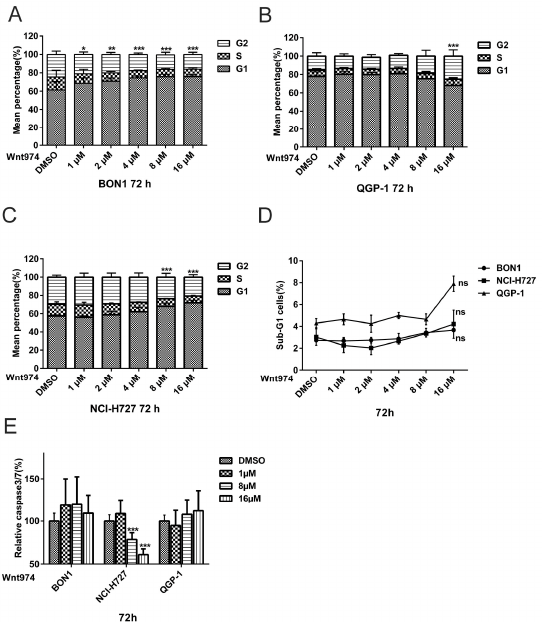
Figure 2. ( A – D ). Effect of WNT974 on cell cycle arrest at the G1, G2/M, and sub-G1 phase. BON1, QGP-1, and NCI-H727 cells were treated with or without WNT974 for 72 h and then subjected to flow cycle metric cell cycle distribution assay. The percentage of cells at each phase of the cell cycle is shown as the mean ± SD of three independent experiments. ( E ). Effect of WNT974 on the regulation of caspase-3/7 activity in NET cells. BON1, QGP-1, and NCI-H727 cells were treated with or without WNT974 for 72 h and then subjected to caspase-3/7 analysis, which shows the mean percentage of caspase-3/7 activity compared to the untreated control (100%) ± SD. * p < 0.05, ** p < 0.01, and *** p < 0.001 compared with that of DMSO control.